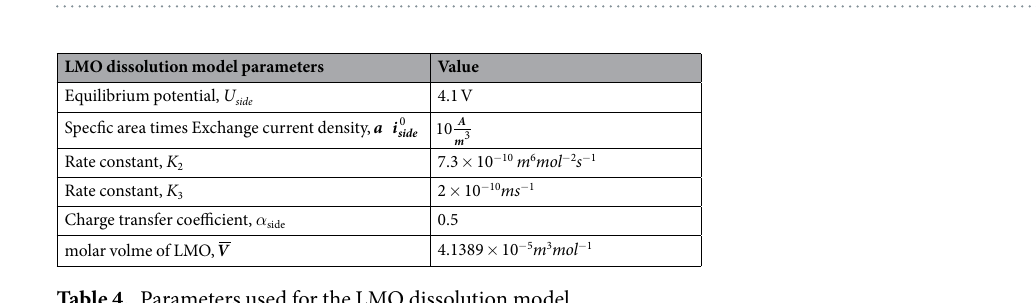
Table 3. Parameters used for the Anode-SEI growth